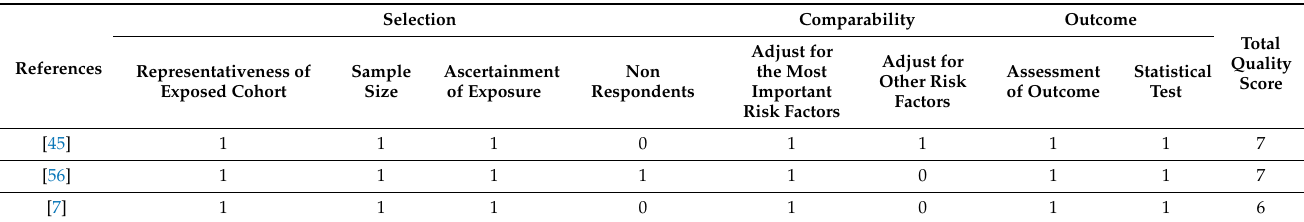
Table 9. Assessment of methodological quality of non-randomized controlled trials (type: Ecological studies), according to the adapted NOS [46].